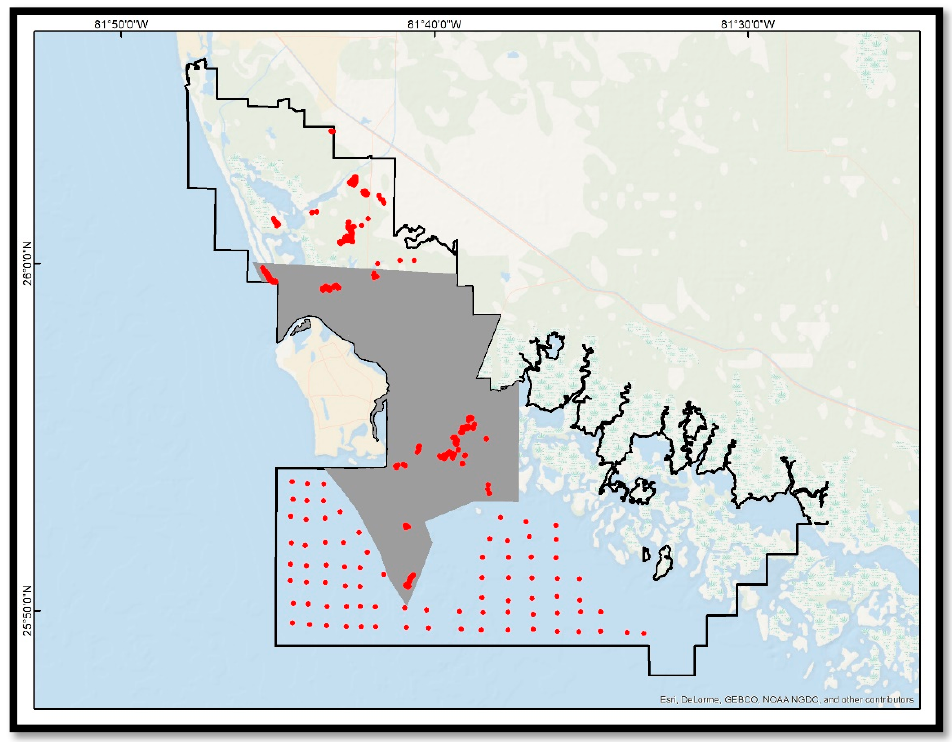
Figure 4. Ground-reference points collected within the Rookery Bay NERR (jurisdiction boundary shown in black) to validate the classified maps (ArcGIS Basemap Source: ESRI). Area of overlap between annual maps that was used for change detection is displayed in grey.